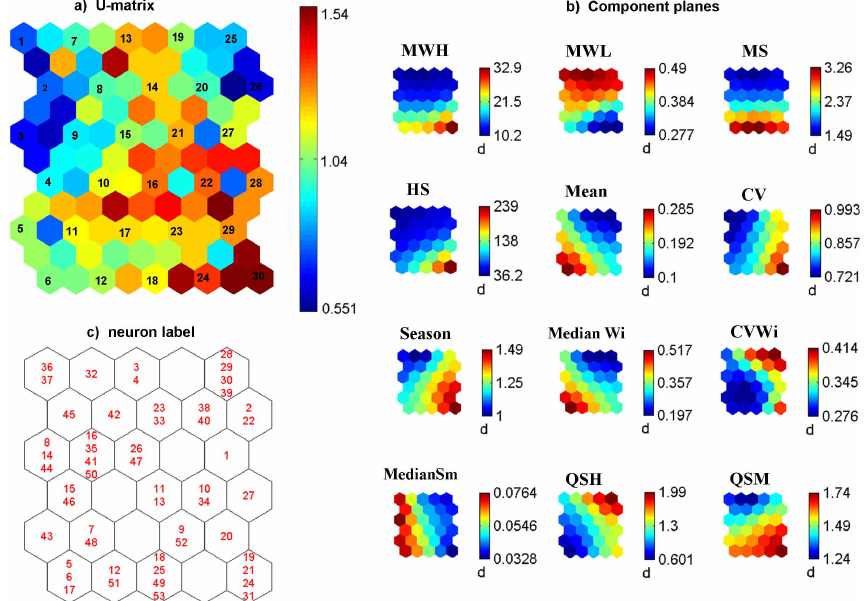
Fig. 4. Visualizations of a SOM: (a) unified distance matrix: neurons of the SOM are indicated by numbers. It shows structures by visualising distances between neighbouring neurons and, on additional hexagons between neurons, median distances between two neurons. (b) Component planes for each index display mean values of each index on the neurons of the SOM. (c) Assignment of catchments to neurons labels catchment IDs to their corresponding BMU1. All visualizations of SOMs are linked by position: in each figure, a certain position corresponds to the same